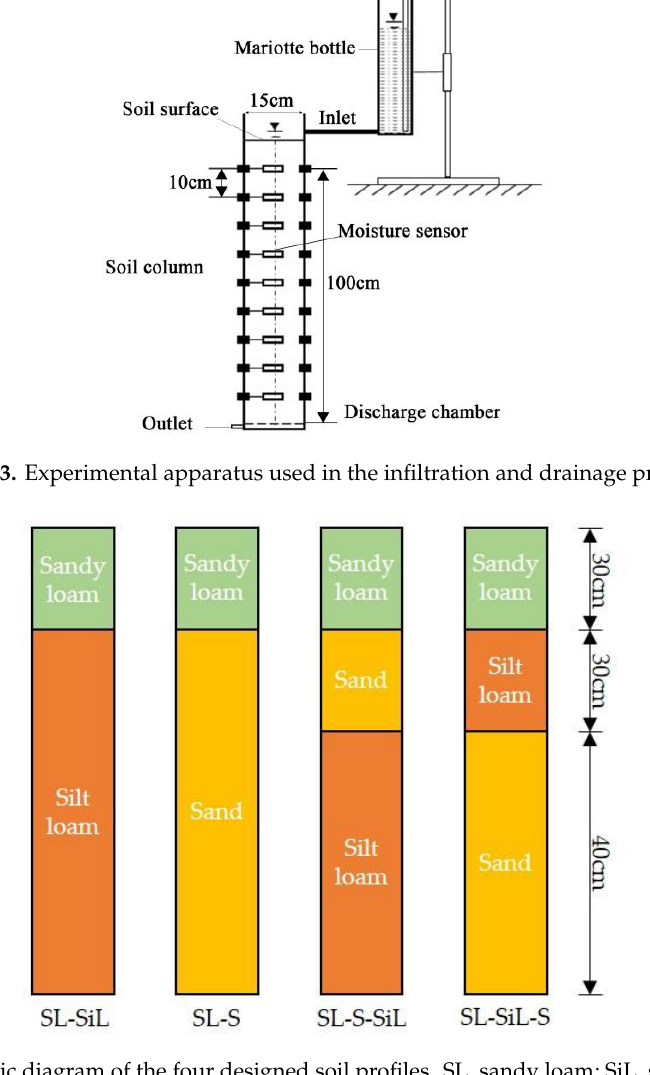
Figure 4. Schematic diagram of the four designed soil profiles. SL, sandy loam; SiL, silt loam; S, sand.